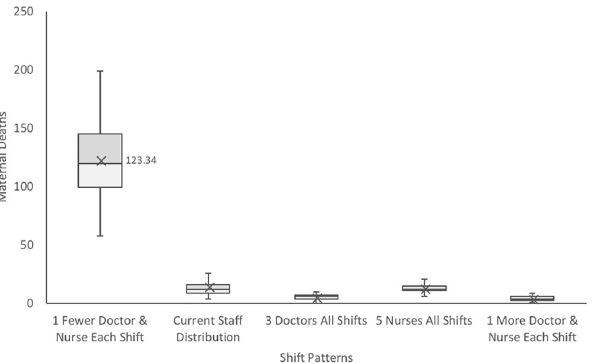
Fig 10. Effect of different staffing distributions during the morning, evening, and night on maternal mortality. Inset depicts zoomed version of shift patterns excluding the 1 fewer doctor and nurse condition. All data sets were found to be statistically significant from one another, except for the current staff distribution compared to the 5 nurses for all shifts, with p < 0.05 using a two-tailed test.